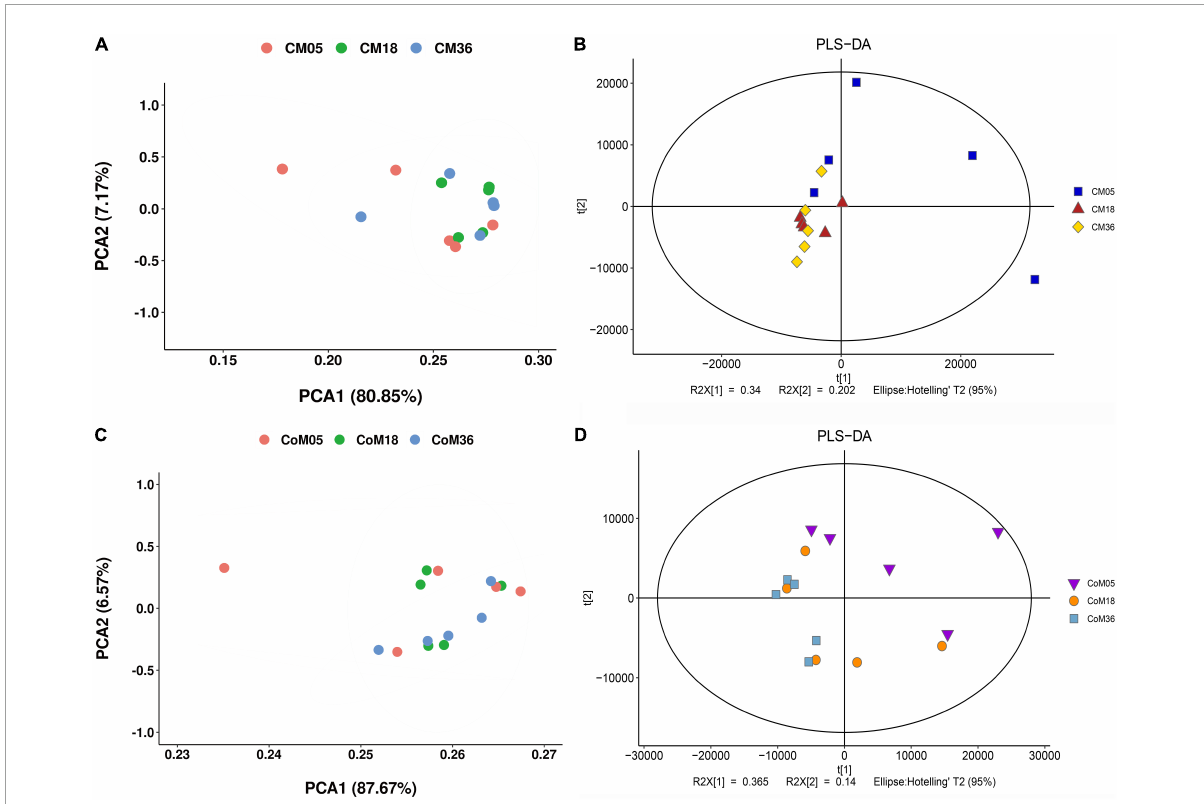
FIGURE4 The cecum and colon metabolome of Mongolian cattle at the 5th, 18th, and 36th months of age. Principal coordinate analysis (PCA) and partial least-squares discriminant analysis (PLS-DA) reveal the metabolites variation in the cecum (A,B) and colon (C,D) , respectively.